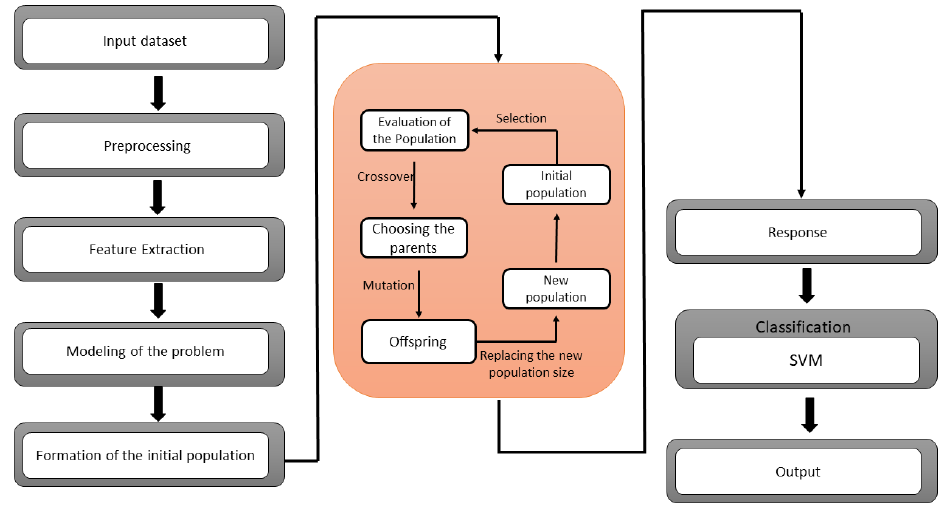
Figure 1. The architecture of the GA-SVM approach. SVM Parameter Optimization Using GA